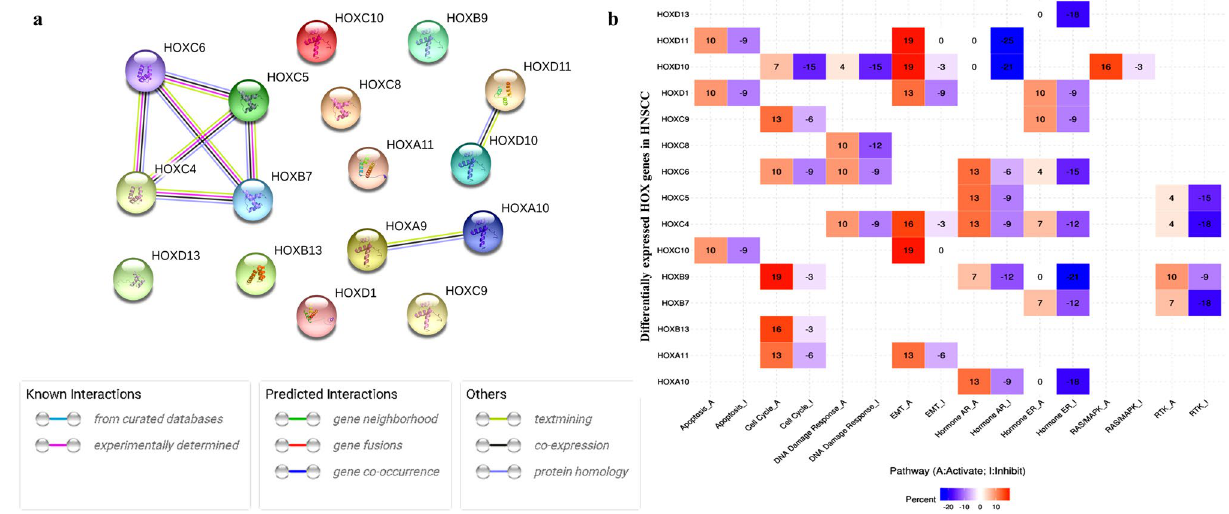
Figure 3. Co-expression analysis: ( a ) Overview of PPI Network of 16 DEHGs, with > 0.7 confidence score constructed using STRING v11.5 database. The network includes 8 edges between 16 nodes that show the co-expression amongst DEHGs. ( b ) Pathway analysis: A heatmap showing DEHGs that activate (A) and inhibit (I) pathways in HNSCC using